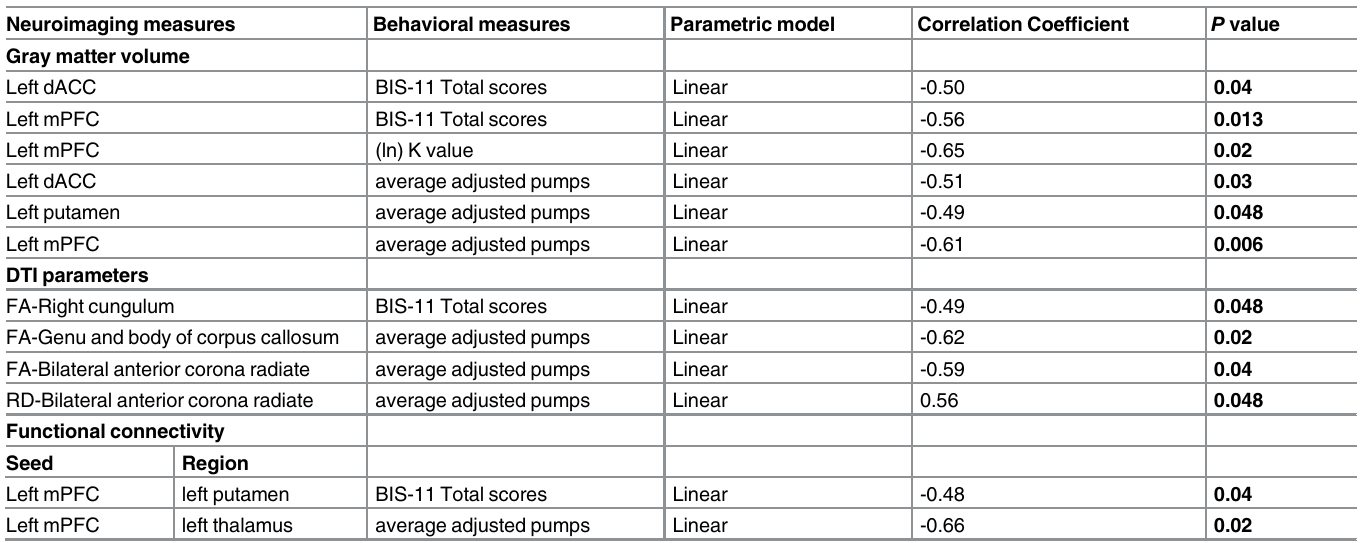
Table 5. Brain-behavior correlations in